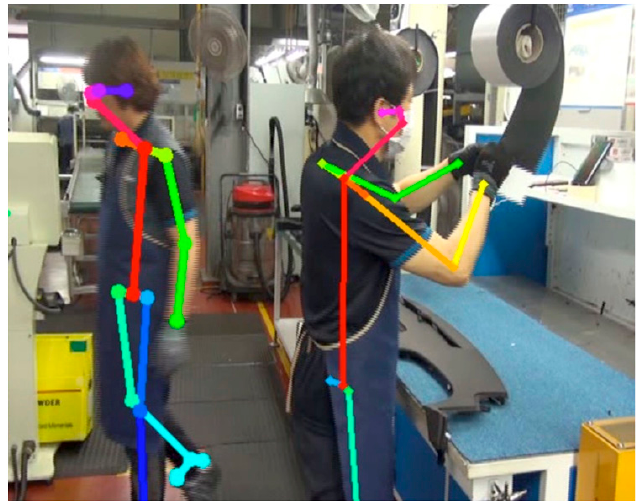
Figure 2. Estimated body pose-estimation results by OpenPose.